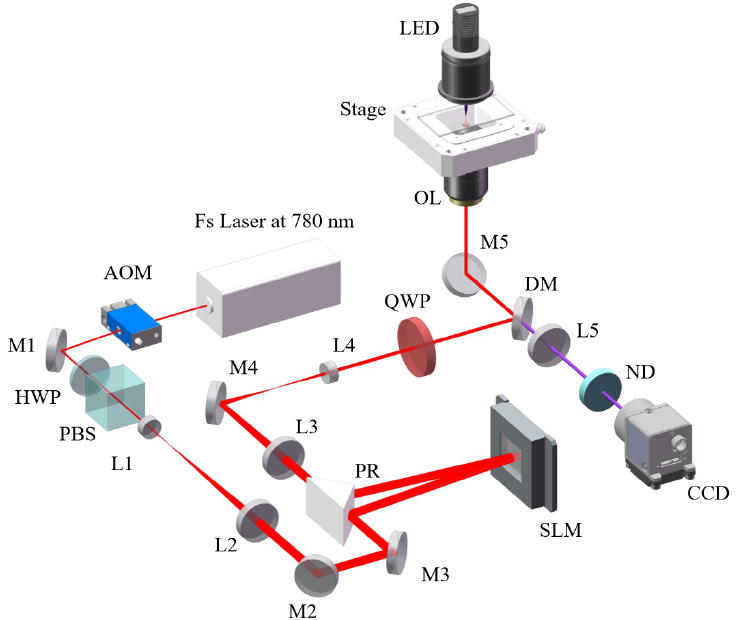
Figure 3. Experimental setup for laser direct writing by MHCBs. Other notations are: HWP, half-wave plate; PBS, polarized beam splitter; M, mirror; SLM, spatial light modulator; QWP, quarter-wave plate; L, lens; AOM, acoustic–optical modulator; PR, prism reflector; OL, objective lens; DM, dichromatic mirror; ND, neutral density